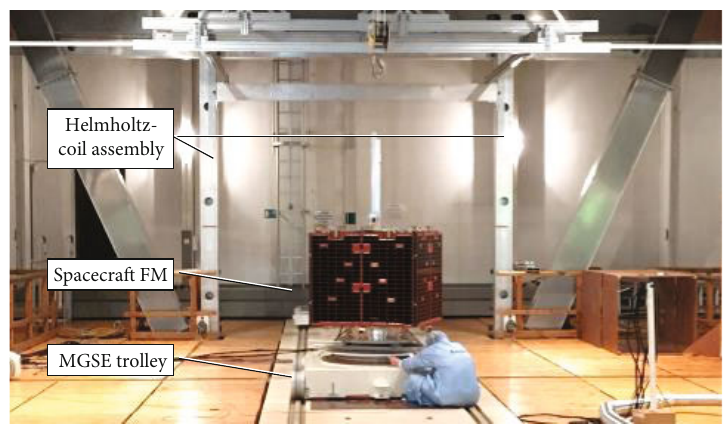
Figure 16: Spacecraft FM during remanent magnetic fi eld measurement at IABG.